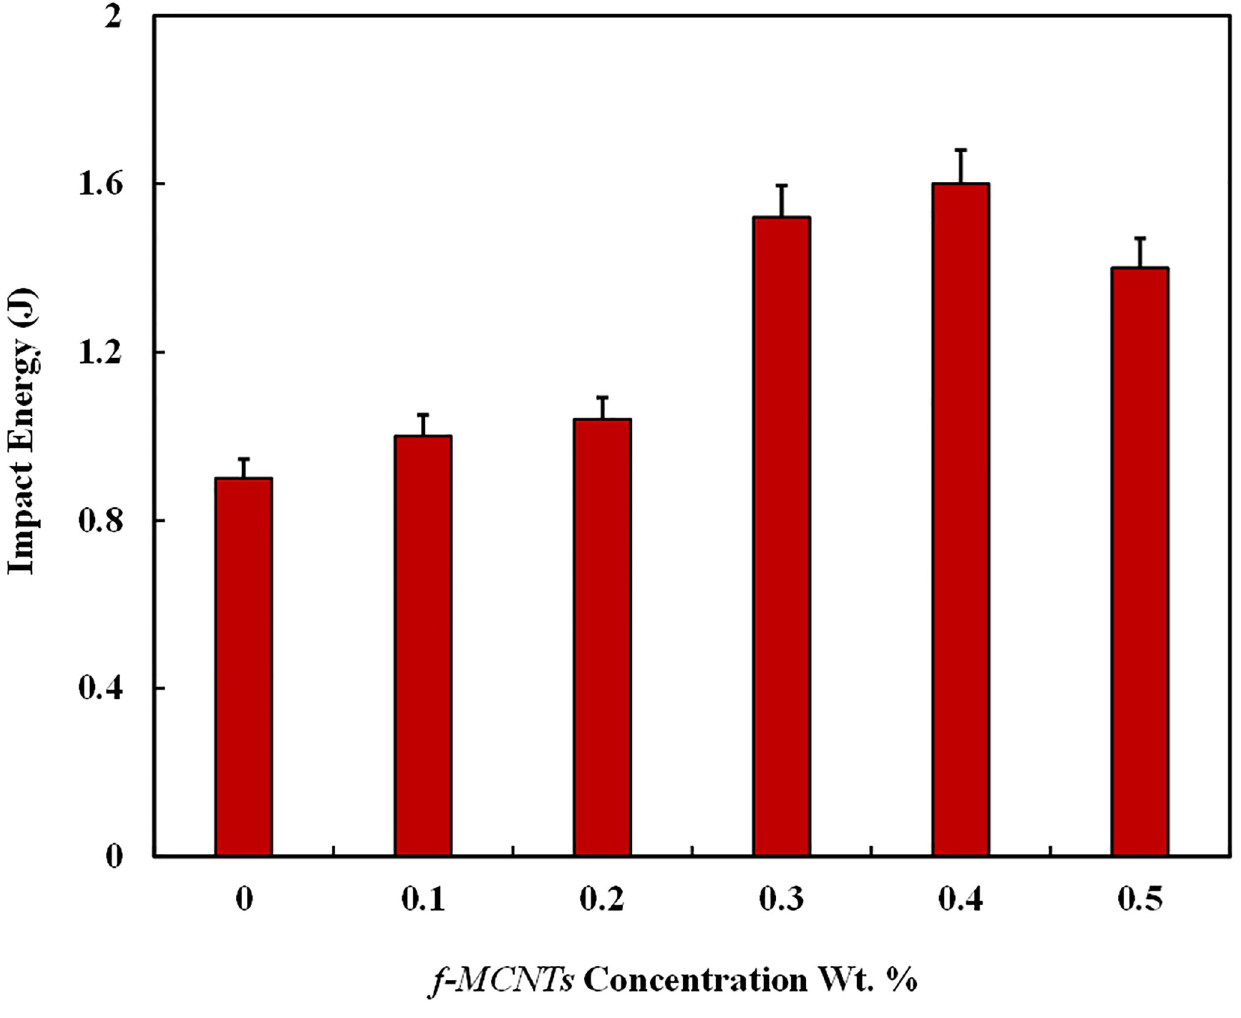
Fig 8. Impact strength of f-MWCNTs modified